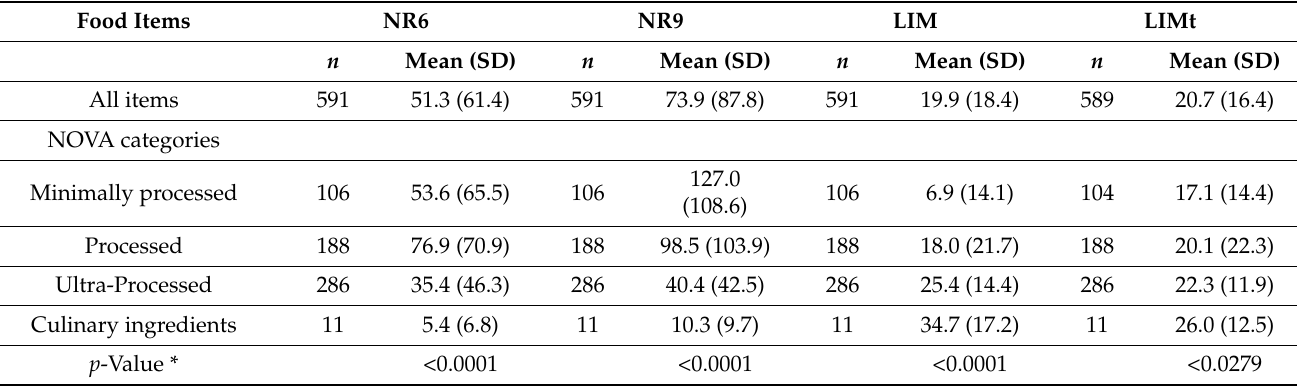
Table 1. Energy density and nutrient density by NOVA categories.